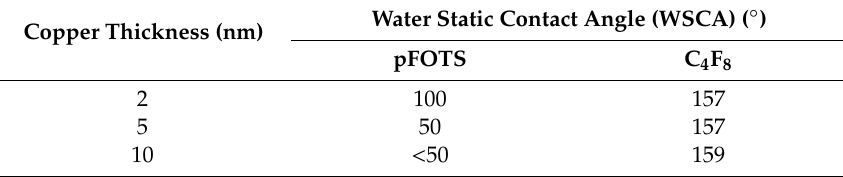
Table 3. Water static contact angle measurements of plasma micro-nanotextured superhydrophobic PMMA surfaces after the deposition of a fluorinated chlorosilane layer from pFOTS or a fluorocarbon layer from C 4 F 8 gas discharge, for various underlying copper film